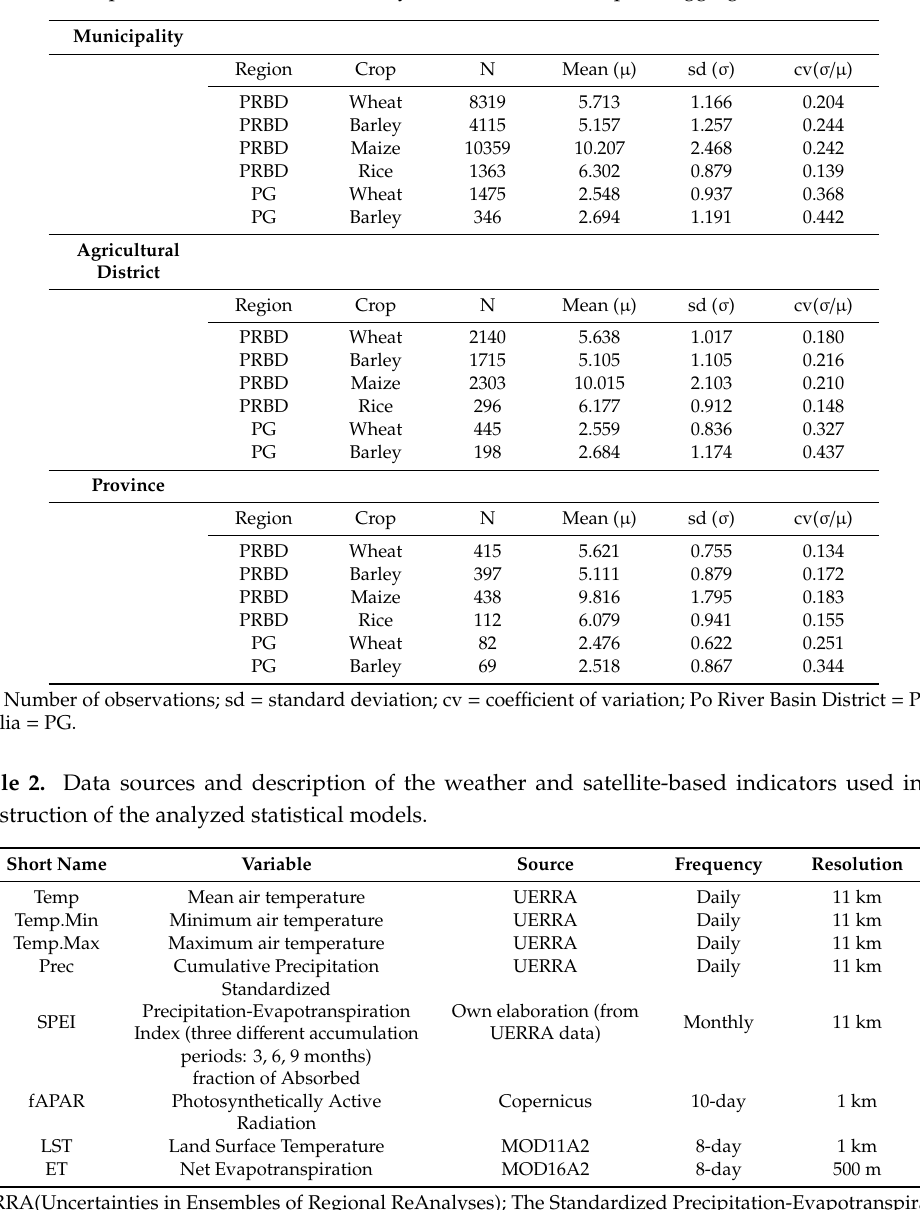
Table1. DescriptivestatisticsofRICA-CREAyielddataatthethreespatialaggregationscalesconsidered.